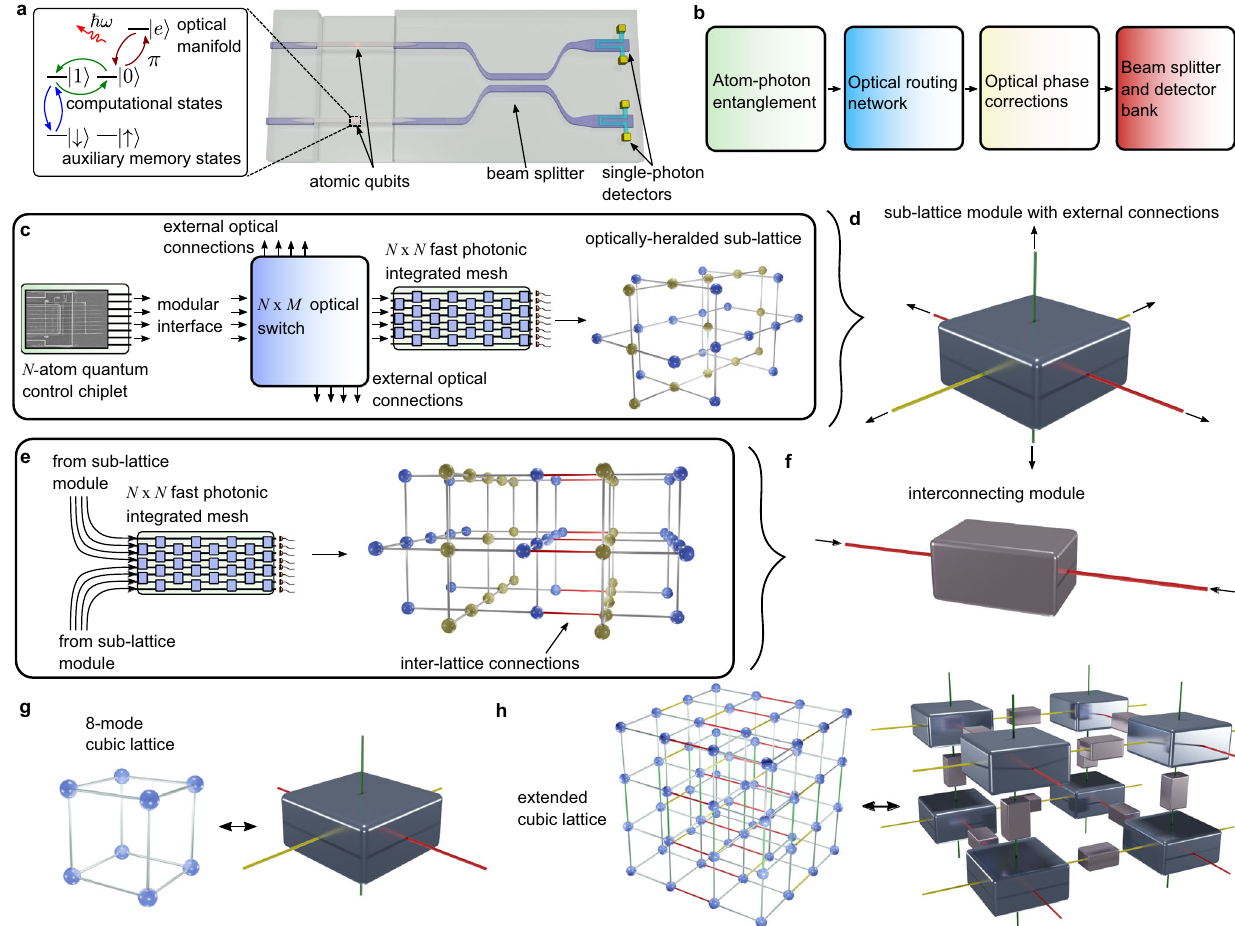
Fig. 1 Modular architecture for generating optical links using programmable photonic integrated meshes. a Diagram of the basic requirements for optically-heralded entanglement generation between two generic atomic qubits. The key components are initialization and control of the computational and auxiliary memory states, an optical transition emitting a photon entangled with the computational states into indistinguishable waveguide modes, a 50:50 beam splitter, and single-photon detectors. b Schematic of the components in a as functional blocks. c Implementation of the block schematic using modular components: an N- atom qubit chiplet is connected to an N × M binary optical switch for photon routing, then connected to an N × N Mach – Zehnder mesh (MZM). The N × N photonic mesh performs the optical phase correction, routing to detectors, and path-erasure functions. This hardware group generates a sub-lattice of the overall quantum state. d Render of a sub-lattice module of functions in c showing external connections to other modules with red, green, and yellow connectors. e Implementation of how interconnects are formed between modules using another N × N MZM, which links the sub-lattices. f Render of the interconnecting module of the functions in e) that links two external connections (colored here in red). g , h An example of how a large-scale cubic lattice may be generated when each sub-lattice module generates a cubic unit